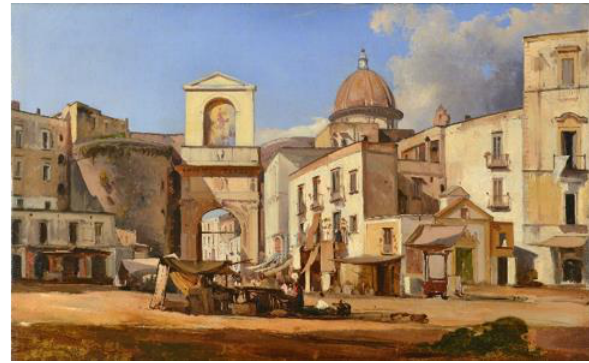
Figure 9. Giacino Gigante (fourth decade of 19th century). Porta Capuana and the dome of Santa Caterina Formiello in the background.